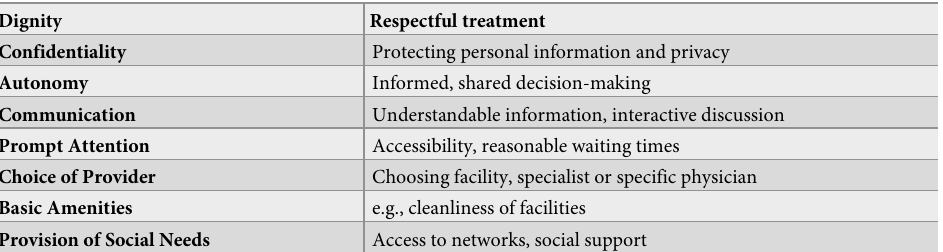
Table 1. Responsiveness domains (WHO